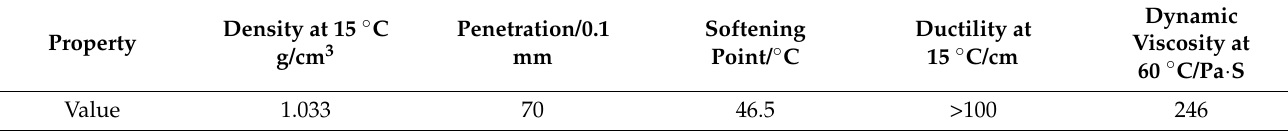
Table 4. The properties of base asphalt.